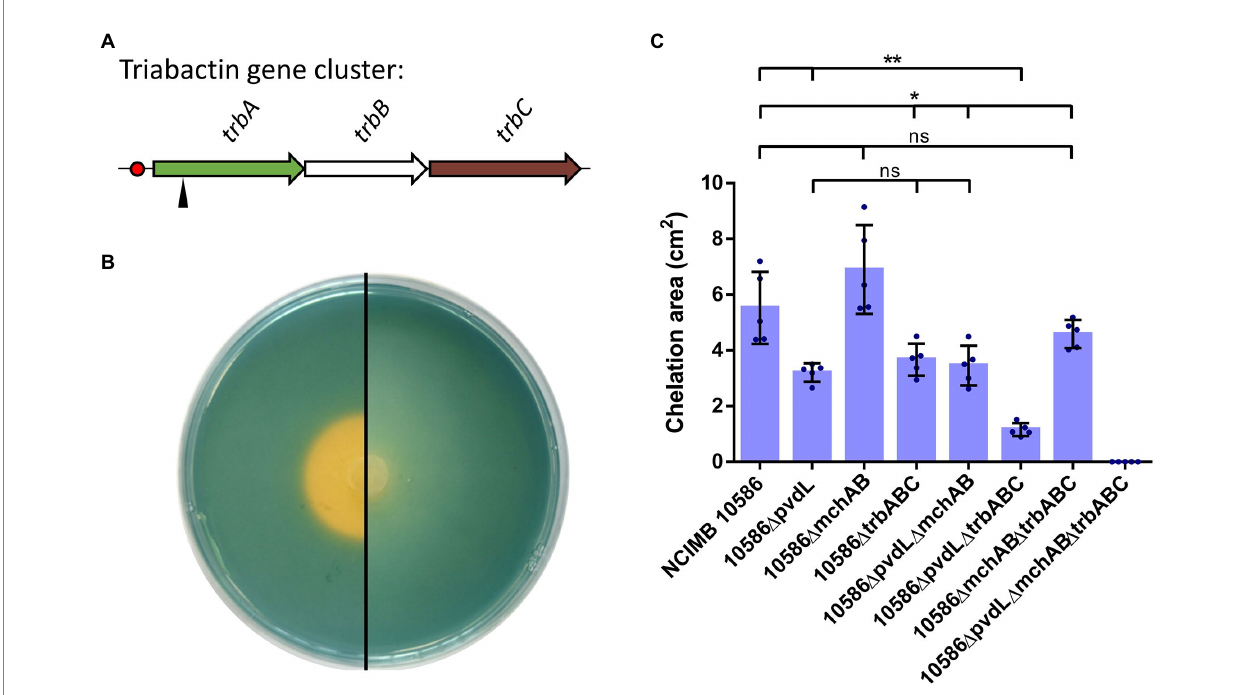
FIGURE 5 A third siderophore named triabactin is produced by Pseudomonas sp. NCIMB 10586. (A) Organization of the trb gene cluster responsible for triabactin biosynthesis and utilization by the strain. trbA: NRPS-independent synthetase, trbB: MFS transporter, trbC: TonB-dependent receptor. The transposon insertion is indicated by a black triangle. Hypothetical Fur-binding site is represented by a red circle. (B) Comparison of the CAS results for the pyoverdine-mupirochelin-negative mutant 10586 ∆ pvdL ∆ mchAB (left) and the pyoverdine-mupirochelin-triabactin-negative mutant